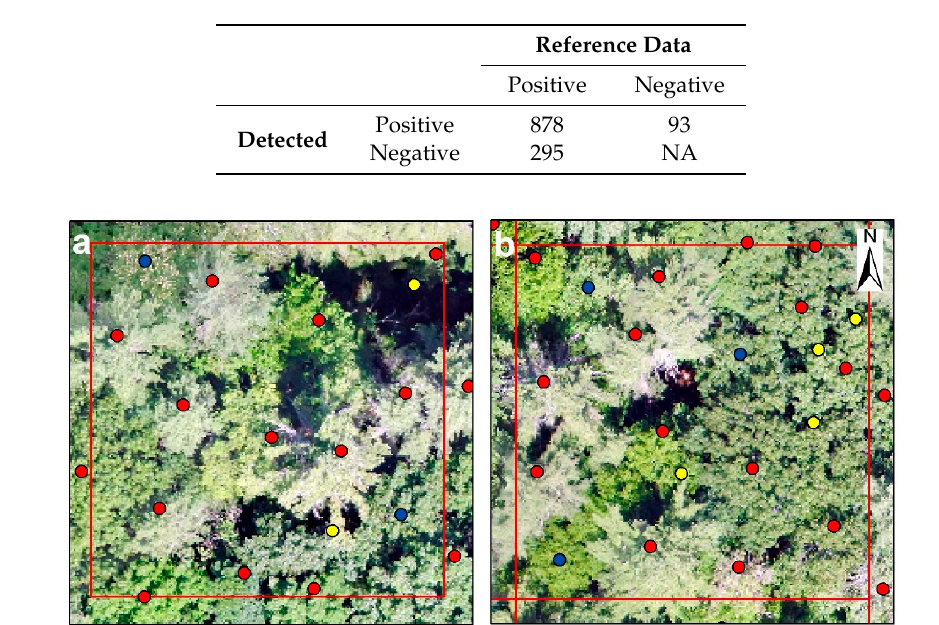
Table 2. Tree detection error matrix.